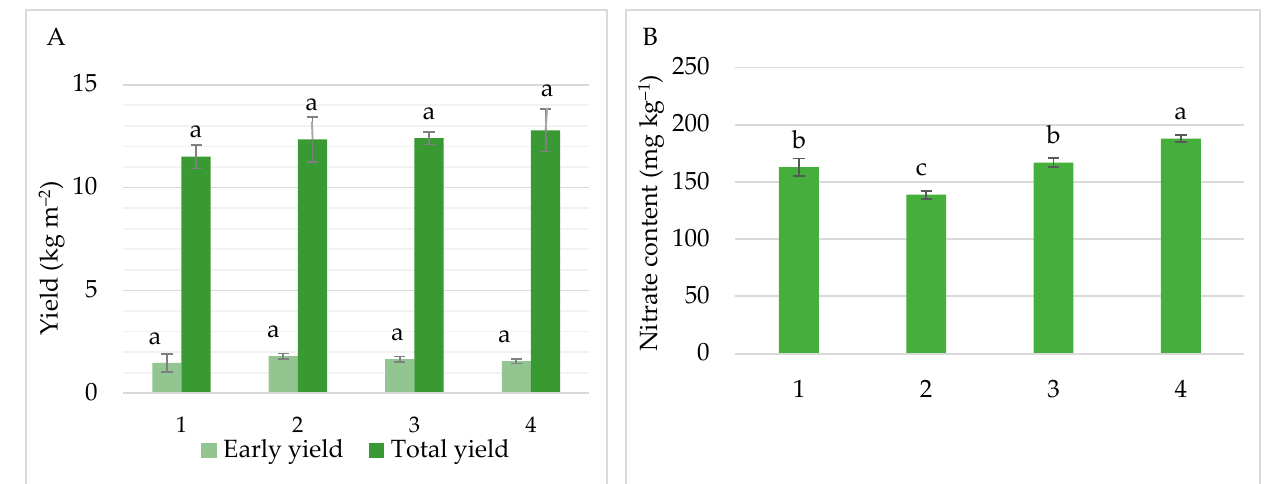
Figure 5. The effect of peat–vermicompost substrates on early and total cucumber yield ( A ), nitrate content in fruit of cucumber ( B ): 1—peat; 2—peat+10% vermicompost; 3—peat+20% vermicompost; 4—peat+30% vermicompost. Means with different letters are significantly different at the p < 0.05 level according to Tukey’s significant difference test. Error bars show standard deviation. The analyzed indices differ significantly between seedlings grown in peat without vermicompost and in peat with different ratios of vermicompost (Figure 6). Peat+10% ver- micompost substrates had the least influence on the investigated indices. Seedlings grown in peat+30% vermicompost substrates had more leaves and the largest leaf area. These seedlings accumulated more minerals in their leaves. This substrate also had the greatest positive effect on photosynthetic parameters in the leaves of the seedlings. High Figure 6. Relationships of peat–vermicompost substrates according to biometric parameters, mac- roelement content and photosynthetic parameters in cucumber seedling leaves.